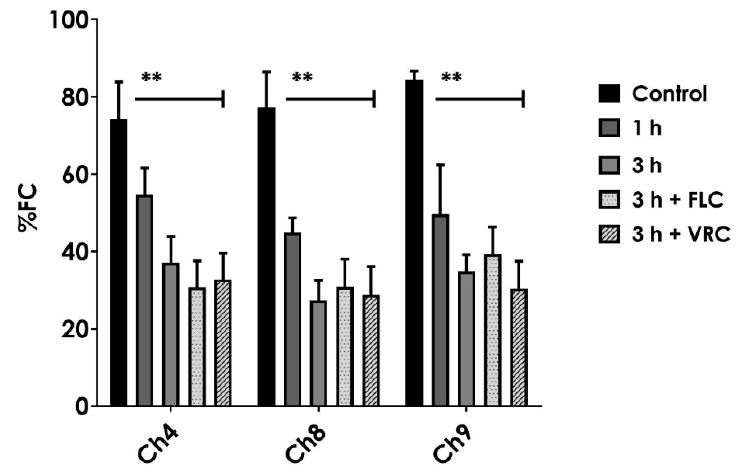
Figure 2. Flow cytometric efflux of rhodamine 6G (R6G) over time among clinical isolates belonging to the C. haemulonii species complex. Data were expressed as the percentage of fluorescent cells (%FC) after the addition of 100 mM of glucose. Some systems were also pretreated for 1.5 h with fluconazole (FLC at 64 mg/L) and voriconazole (VRC at 16 mg/L) prior to the R6G and glucose supplementation. Fungal species: C. haemulonii LIPCh4 (Ch4), C. duobushaemulonii LIP Ch 8 (Ch8), and C. haemulonii var . vulnera LIP Ch 9 (Ch9). The results were expressed as the mean ± standard deviation of three independent experiments, and the symbol (**) represents p values ≤ 0.01 when compared to control (one-way ANOVA, Bonferroni post hoc test).